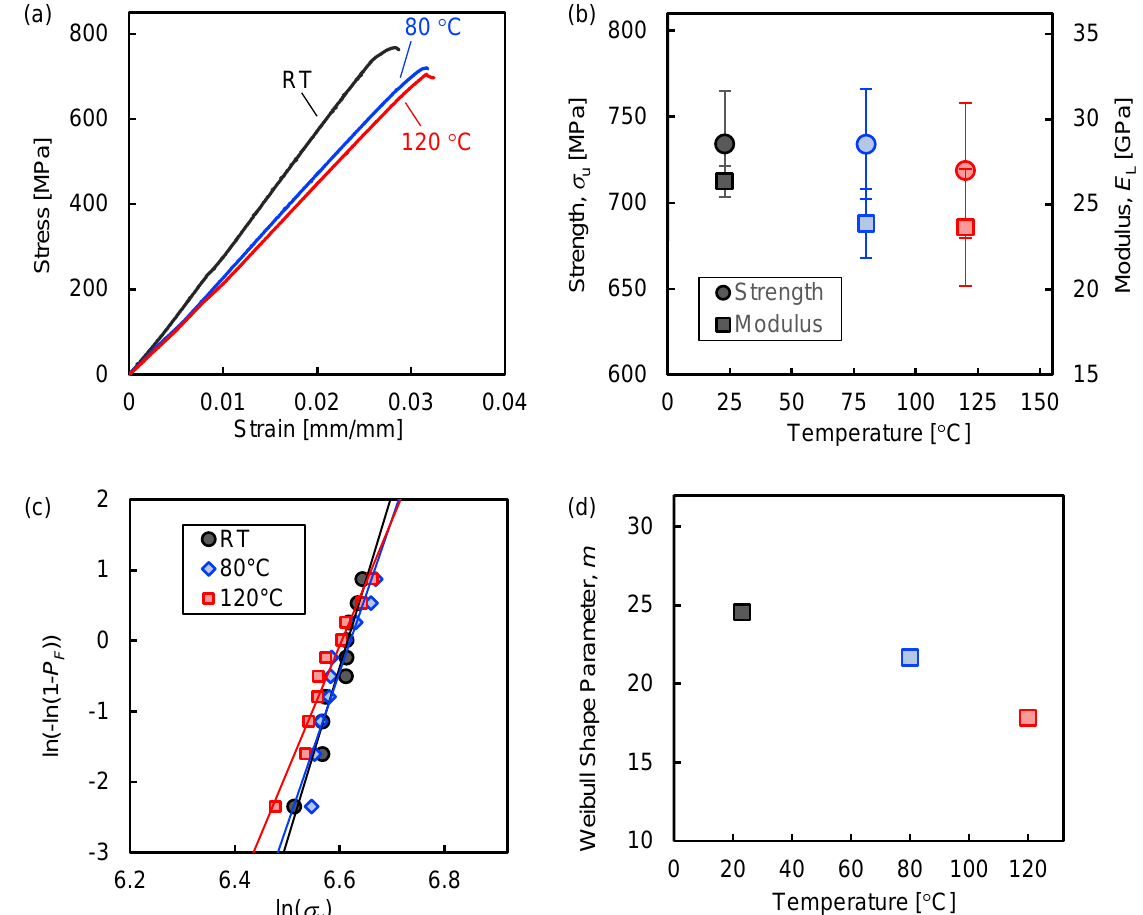
Figure 3. ( a ) Representative stress–strain curves for tensile tests, ( b ) a summary of the tensile properties at each temperature; ( c ) Weibull plot of tensile strengths, and ( d ) Weibull shape parameters at each temperature.